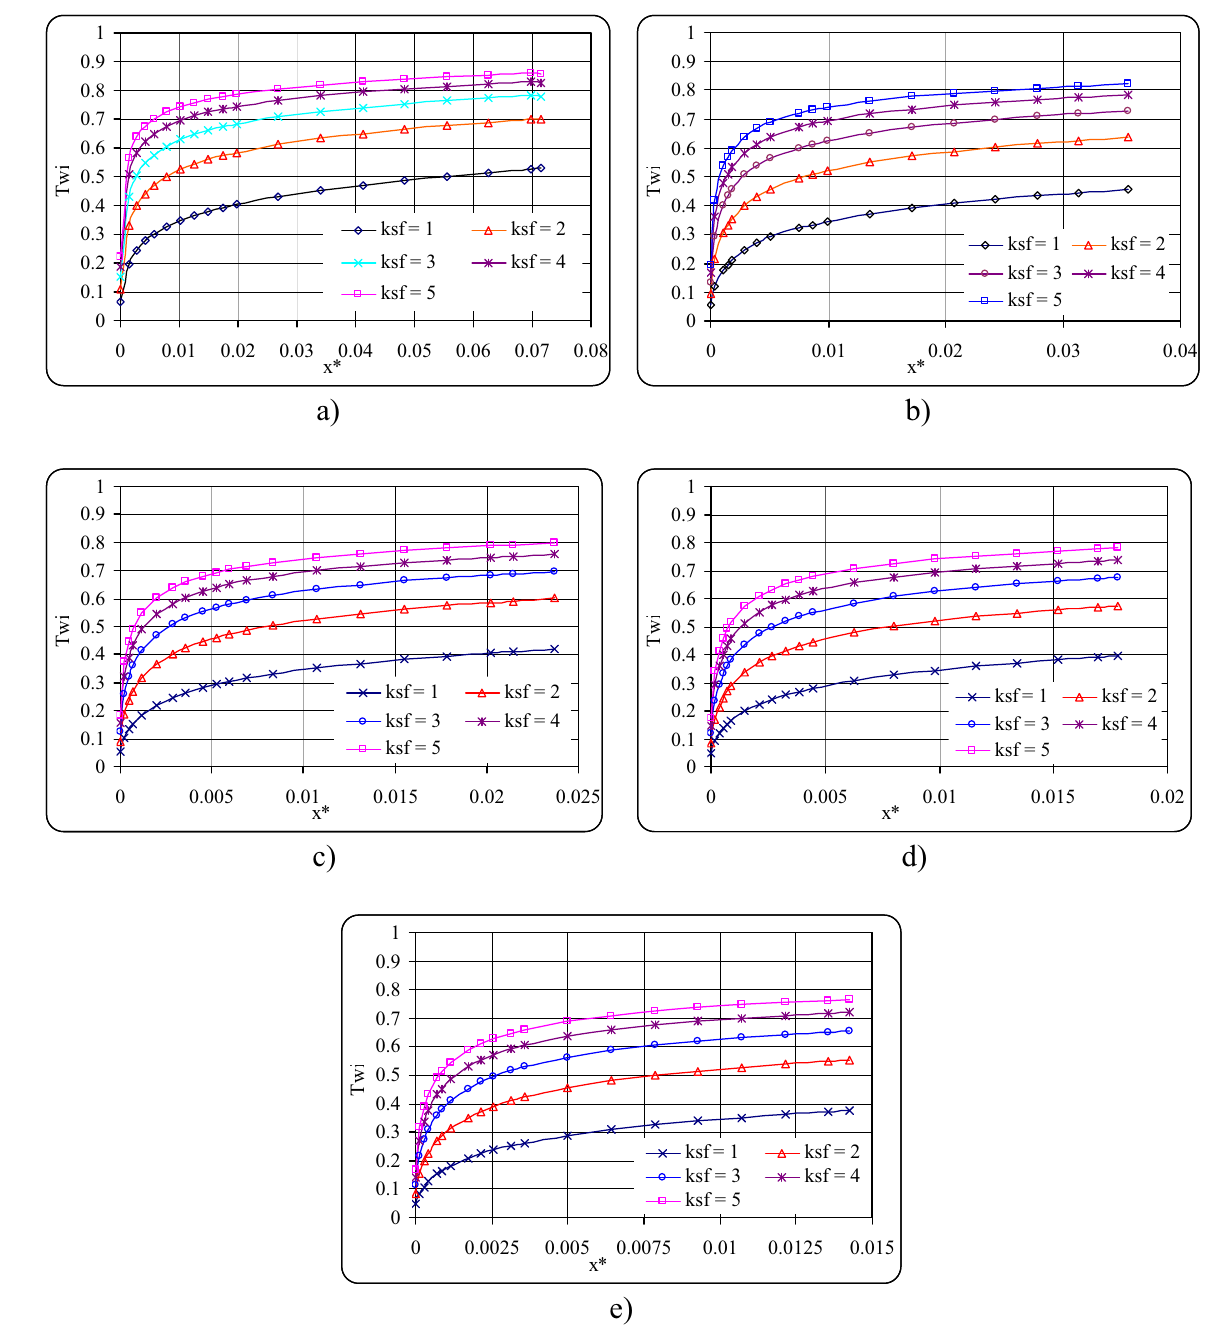
Figure 5: Relationship between dimensionless inside wall temperature vs dimensionless axial coordinate δ /R i = 0.75 and Pr = 7, with variable ksf ratio. ( a ) Re = 200, ( b ) Re = 400, ( c ) Re = 600, ( d ) Re = 800, and ( e ) Re =